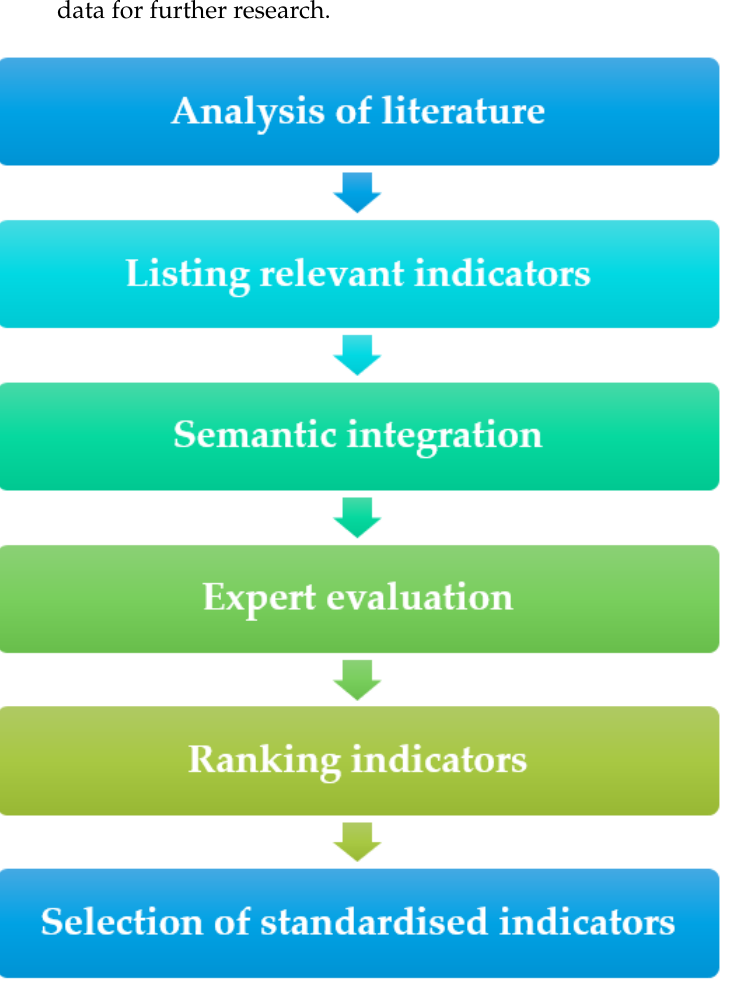
Figure 1. Methodology of the selection and assessment of key green indicators related to the automotive industry in line with GreenPLM concept (own elaboration).